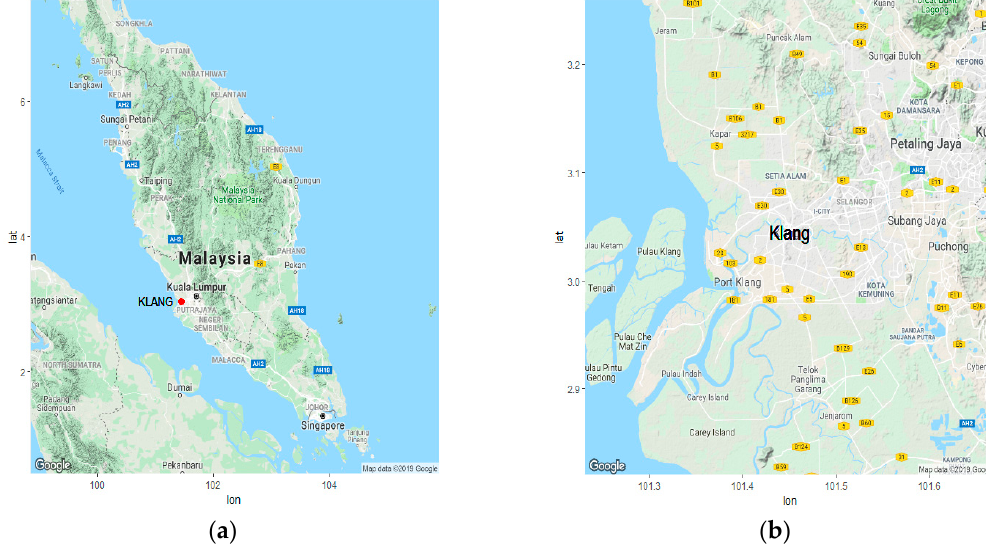
Figure 1. ( a ) Map of peninsular Malaysia (the location of Klang is marked by the red dotted point); and ( b ) map of Klang.